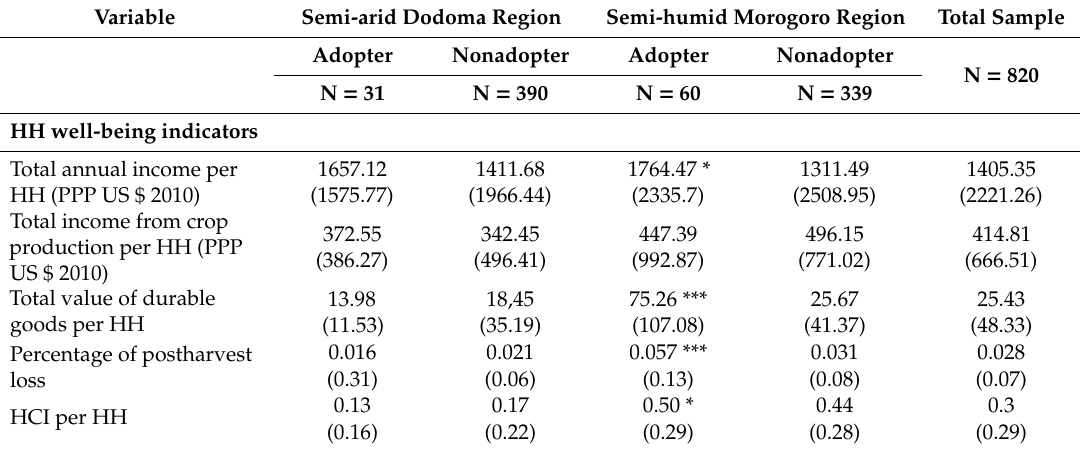
Table A4. Well-being indicators of rural farmers in